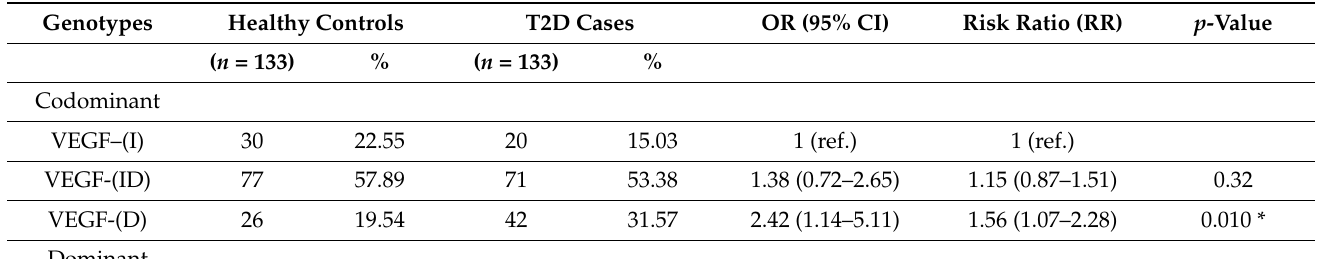
Table 8. Association of VEGF -2549 I/D polymorphism with